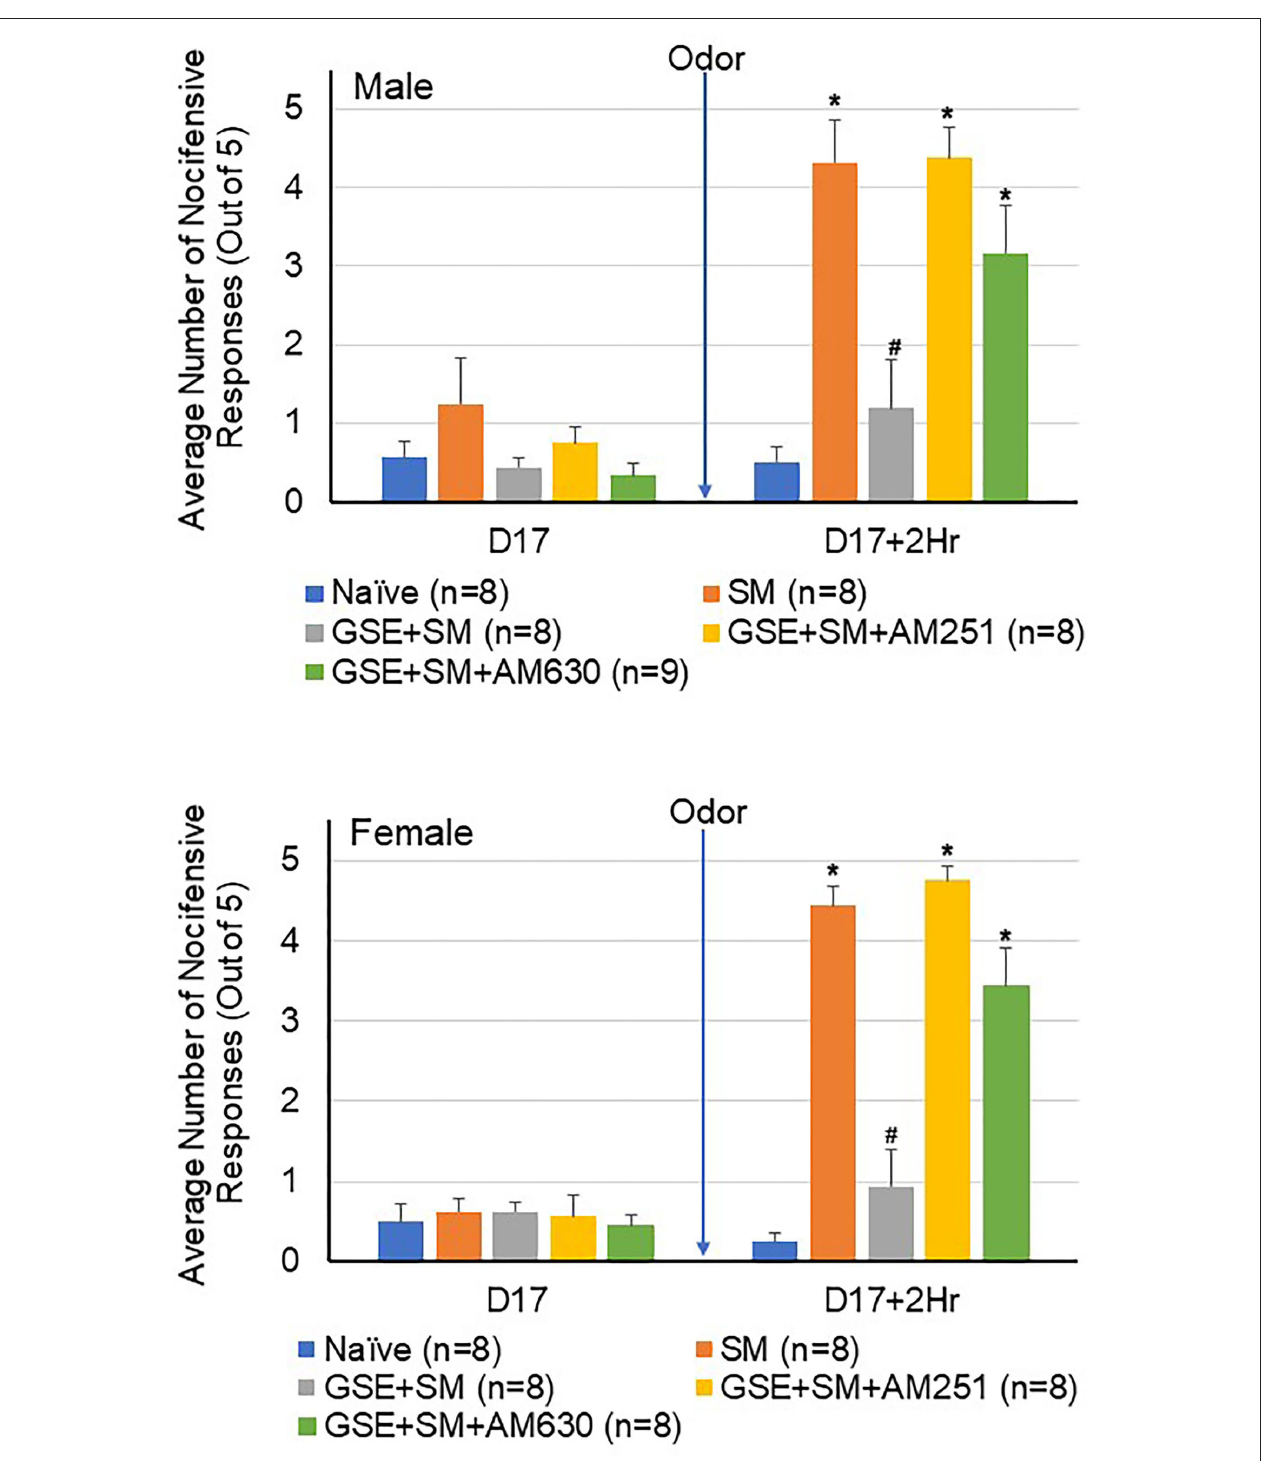
FIGURE 3 | The anti-nociceptive effect of GSE involves CB1 and CB2 receptors. The average number of nocifensive head withdrawal responses to mechanical stimulation is reported for male (top panel) and female (bottom panel) animals. Some animals were left untreated (Naïve) while other animals were subjected to restraint stress (SM). Some animals received daily GSE in lieu of water for 1 week prior to restraint stress and supplementation was continued for remainder of study (GSE + SM). The GSE + SM + AM251 animals received intracisternal injection of the CB1 antagonist AM251 while the GSE + SM + AM630 animals were injected with the CB2 antagonist immediately before exposure to the pungent odor. * P < 0.05 when compared to Naive levels for that condition, # P < 0.05 compared to SM levels.